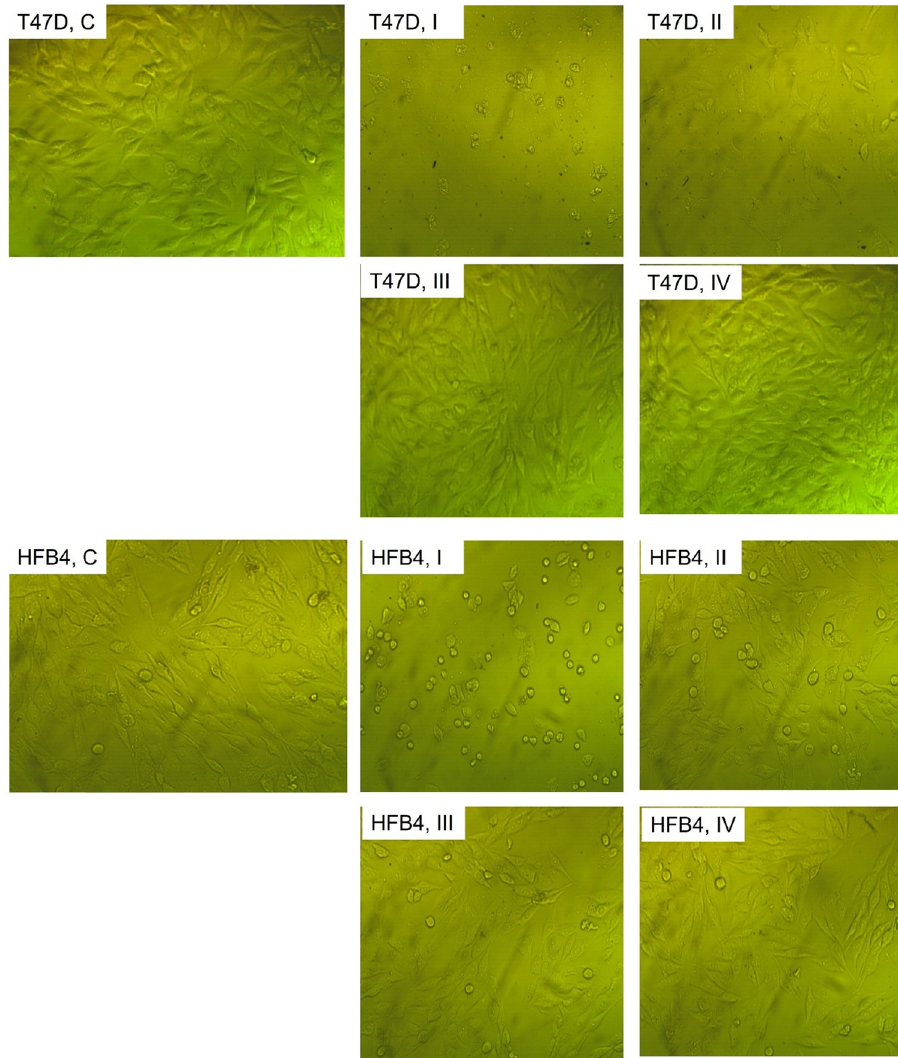
Figure 8: Morphological changes in cancer and normal cell lines due to treatment by various concentrations of CuO - NPs. T47D, C and HFB, C denote the control ( without treatment ) ; T47D, I; T47D, II; T47D, III, and T47D, IV refer to the shape of cancer cell lines T47D after treatment with 50, 25, 6.25, and 3.12 μ g · mL – 1 , respectively; HFB4, I; HFB4, II, HFB4, III, and HFB4, IV refer to the shape of normal cell lines HFB4 after treatment with 50, 25, 6.25, and 3.12 μ g · mL – 1 ,